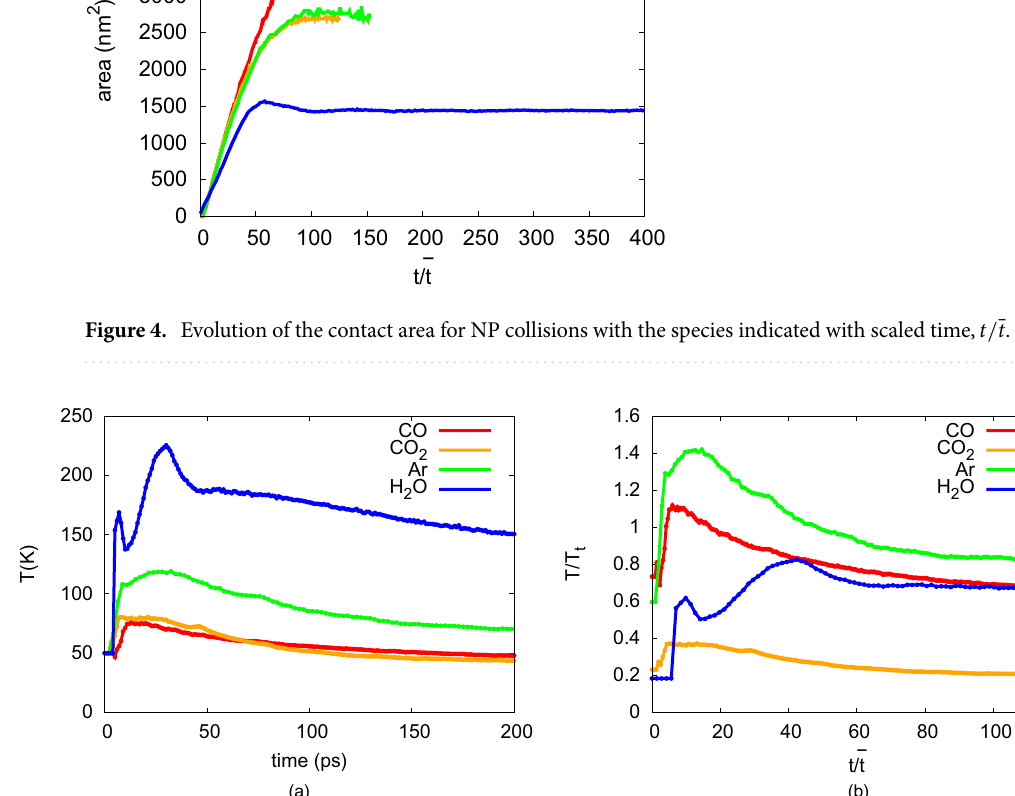
Figure 5. ( a ) Time evolution of the temperature in the collision zone for NP collisions with the species indicated. ( b ) displays the same data relative to the triple-point temperature, T t